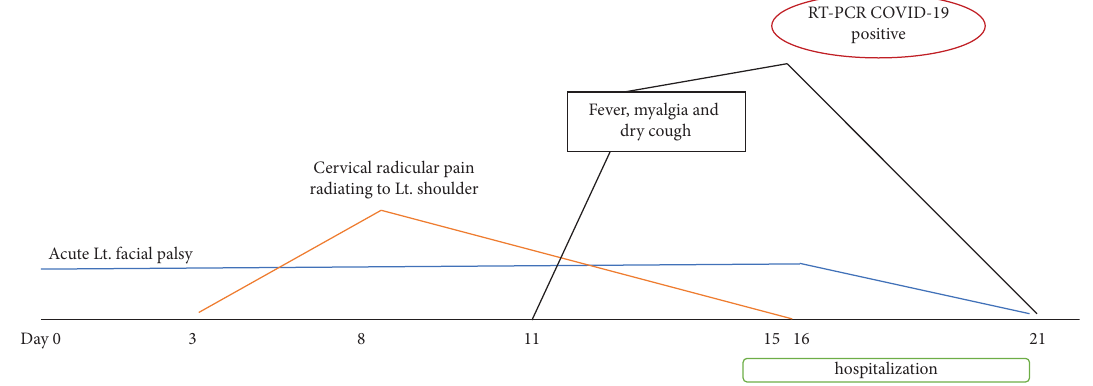
Figure 1: Illustration of clinical course of the reported patient.